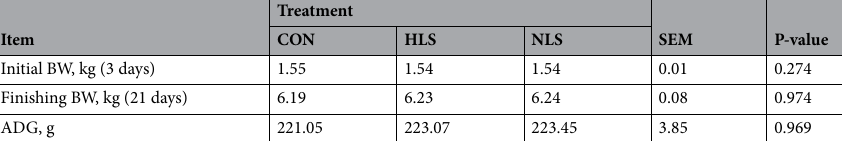
Table 4. Effect of dietary supplementation of Lactobacillus salivarius on piglet growth performance. CON, Control; HLS, L. salivarius 144 isolated from fast-growing pig feces; NLS, L. salivarius 160 isolated from normal weight pig feces. BW, body weight; ADG, average daily